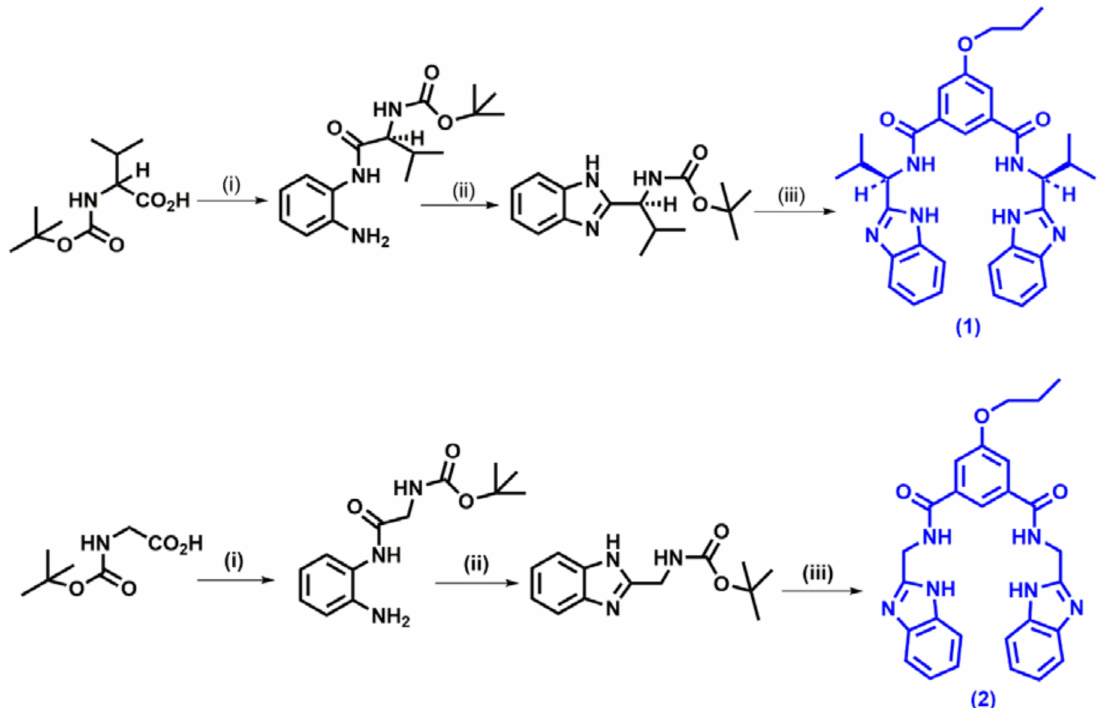
Figure 4. Synthesis of rhodamine derivatives (1 and 2) as the sensors for the detection of Hg 2+ and Cu 2+ . (i) o-phenylenediamine, N,N’-Dicyclohexylcarbodiimide (DCC), 4-Dimethylaminopyridine (DMAP), stirred in CH 2 Cl 2 for 19 h; (ii) AcOH, heat; (iii) 50% trifluoroacetic acid (TFA) in CH 2 Cl 2 , stirred for 3 h. Reproduced with permission from [22] by Royal Society of